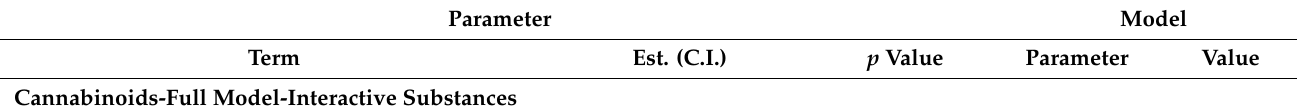
Table 4. Cont. Parameter